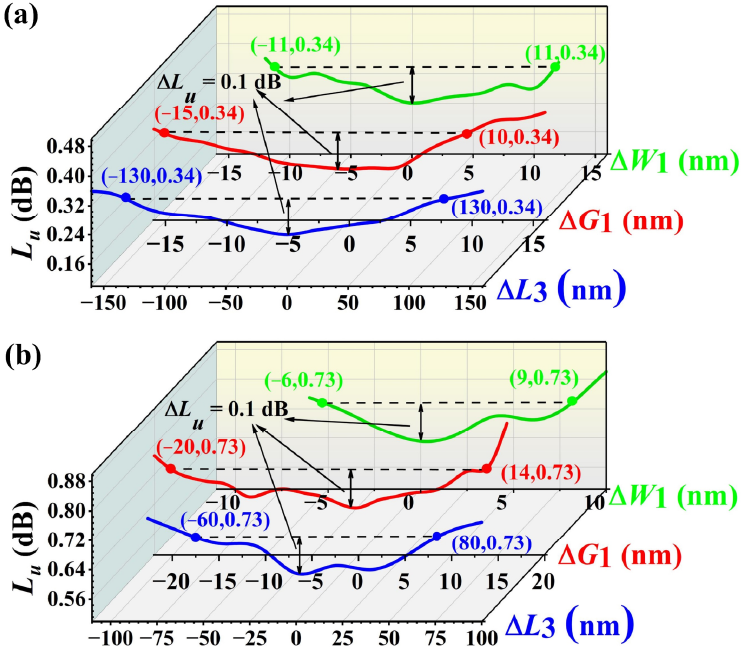
Figure 7. Simulated non-uniformity for ( a ) 8 and ( b ) 16-channel nanowire-assisted AWG with the variation of Δ W 1 , Δ G 1 and Δ L 3 .